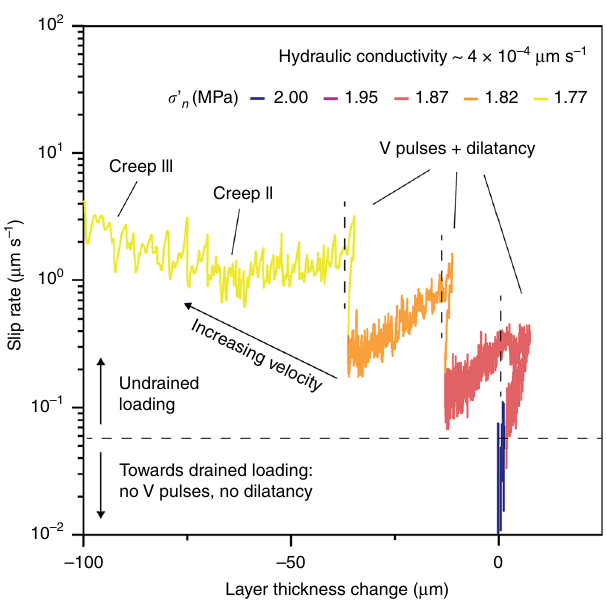
Fig. 4 Evolution of dilatancy/compaction, slip rate, and creep style during pore-pressure steps. Applied shear stress: 0.86 τ s (see Fig. 3). The different colors refer to different values in the effective normal stress as reported in the caption. When the slip rate along the experimental shear zone exceeds a threshold (here 0.05 μ m s − 1 ), loading conditions become markedly undrained. For these conditions, each pore pressure step is associated to acceleration and dilation followed by compaction and the attainment of a new long-term Creep II-velocity ( V CII ): note that V CII increases with increasing pore pressure.